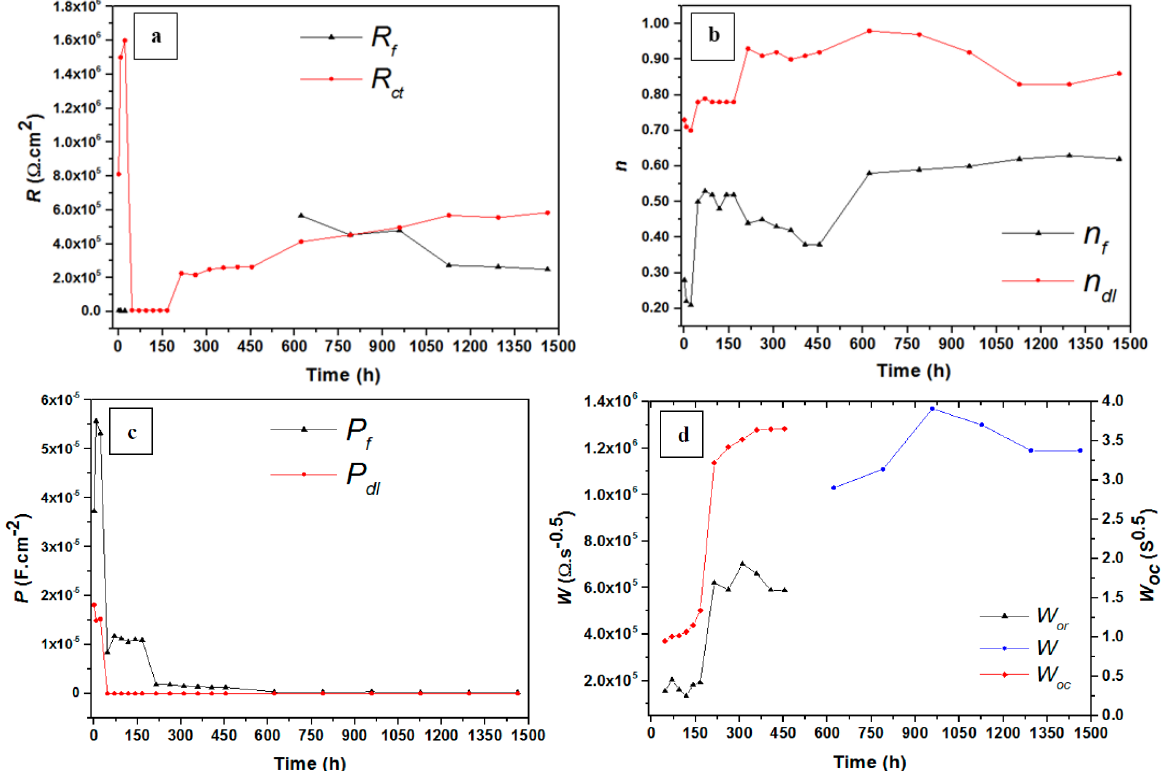
Figure 8. The relationship between different EIS parameters of the coated sample listed in Table 2, ( a ) Resistance values “ R ”; ( b ) deviation parameters “ n ”; ( c ) CPE magnitudes “ P ”, and ( d ) finite/infinite Warburg coefficients “ W or ” and Warburg exponent “ W oc